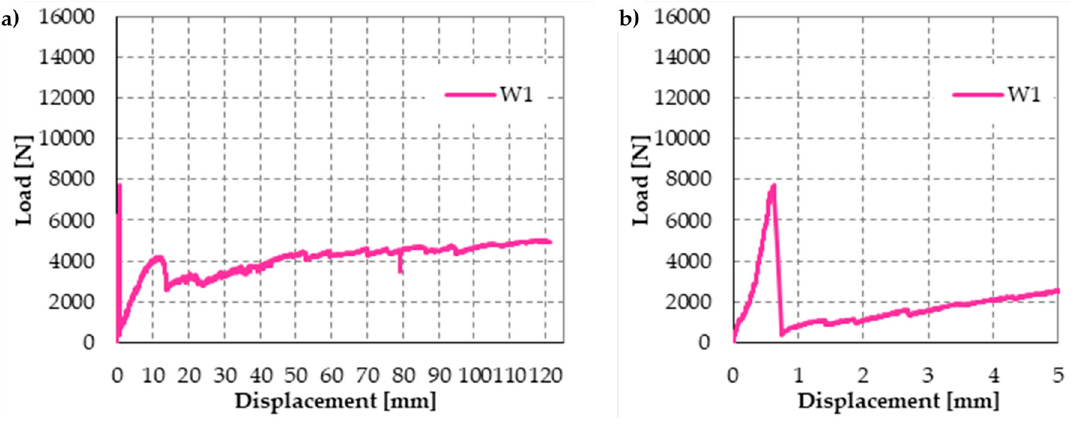
Figure 41. Load/displacement diagram of Specimen W1: ( a ) complete diagram and ( b ) detail of the first peak of load, with a magnified scale factor for the displacement axis.